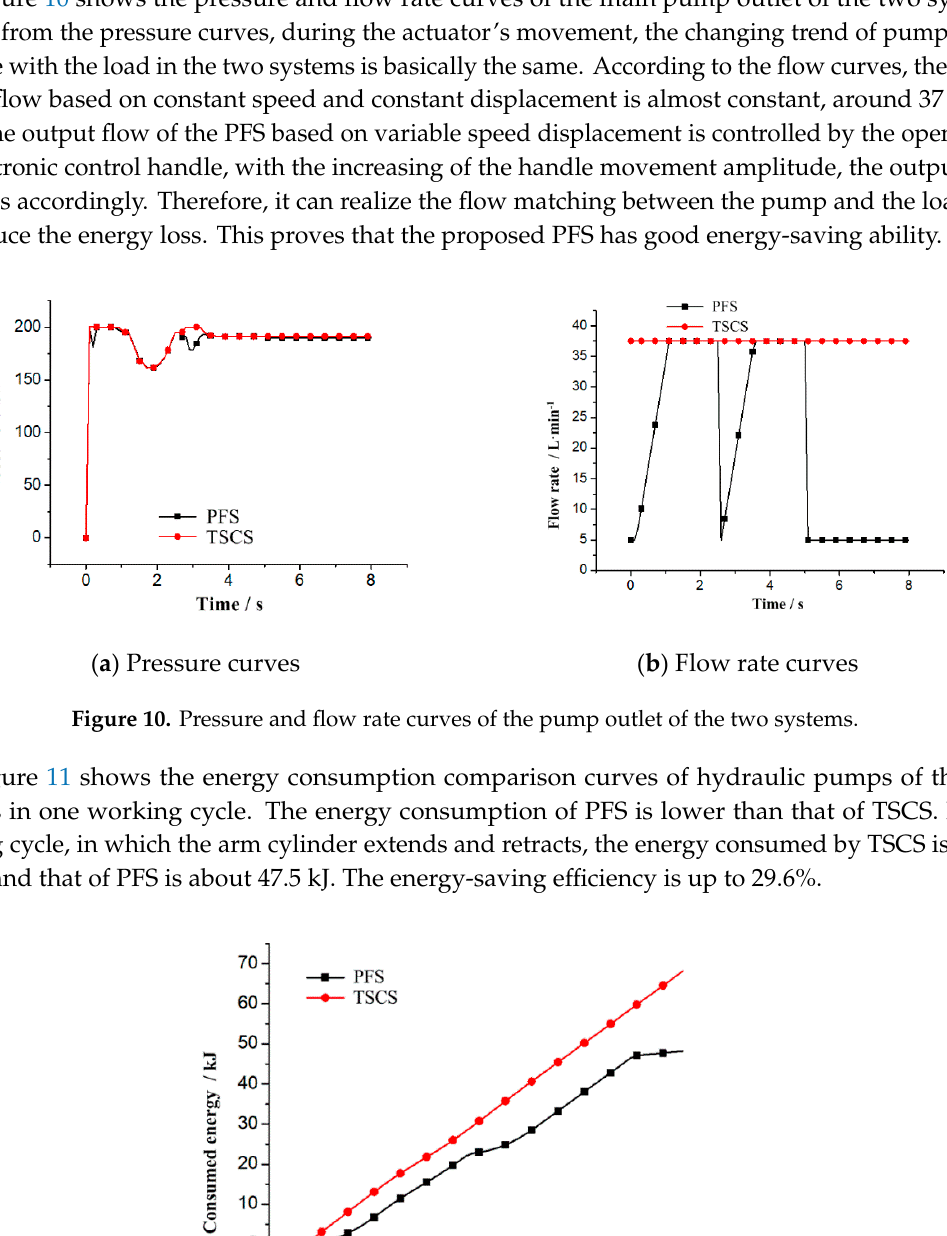
Figure 9. Velocity curves of the arm cylinder of the two systems.